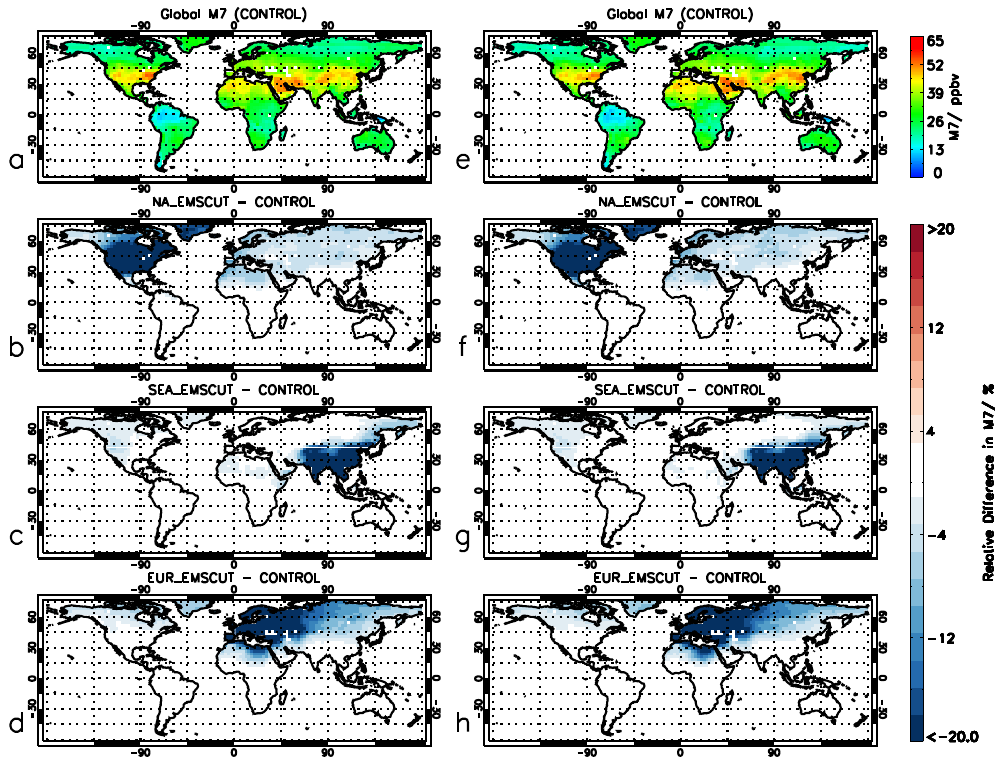
Fig. 8. As Figure 7 but for the M7